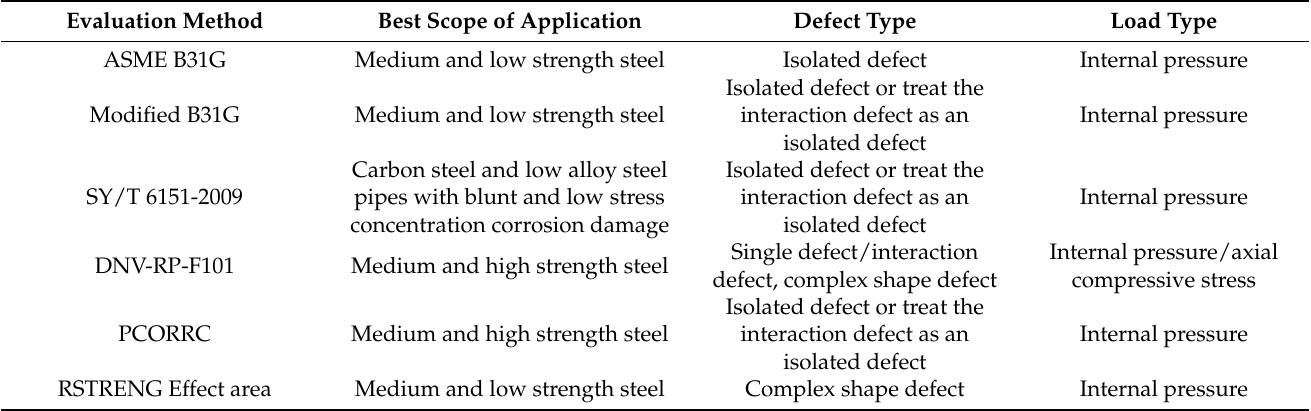
Table 2. Comparison of residual strength evaluation methods for pipes with different corrosion